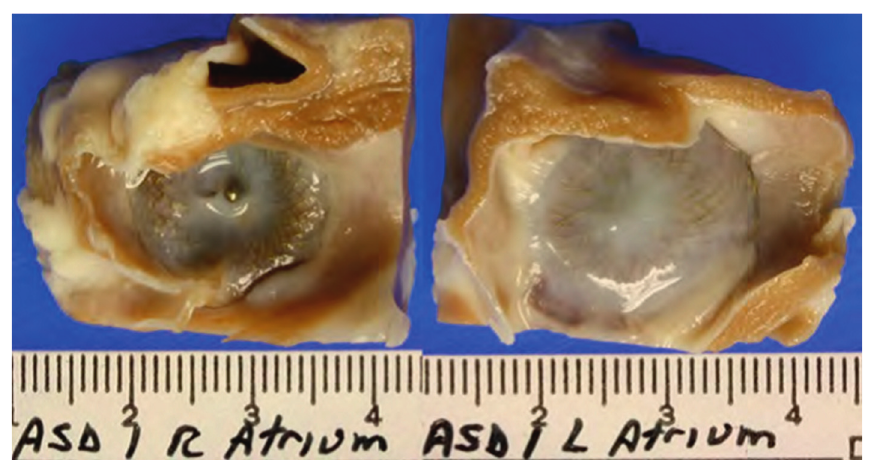
Figure 2: ASD device